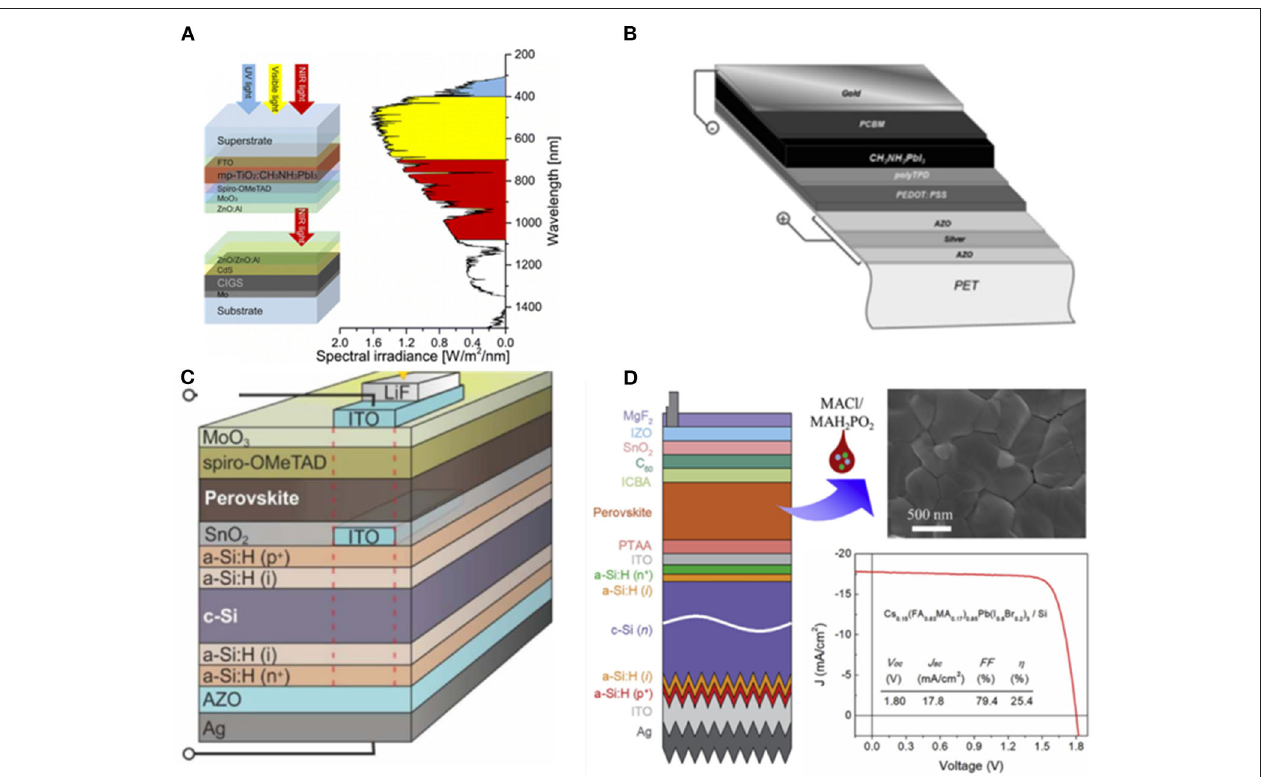
FIGURE 3 | (A) Characterization of NIR-transparent PVSK cells (reproduce from ref. 26, copyright 2015, ACS). (B) Schematic layout of the flexible PVSK solar cell and chemical structure of the materials used as the electron and hole blocking layer (reproduced from ref. 27, copyright 2014, Royal Society of Chemistry). (C) Schematic device design of the Si heterojunction/PVSK tandem solar cell (reproduced from ref. 28, copyright 2016, Royal Society of Chemistry). (D) Schematic structure, J-V curves of Cs 0.15 (FA 0.83 MA 0.17 ) 0.85 Pb(I 0.7 Br 0.3 ) 3 /Si tandem device under forward and reverse scans with an inset photograph of the tandem device (reproduced from ref. 13, copyright 2017, Elsevier